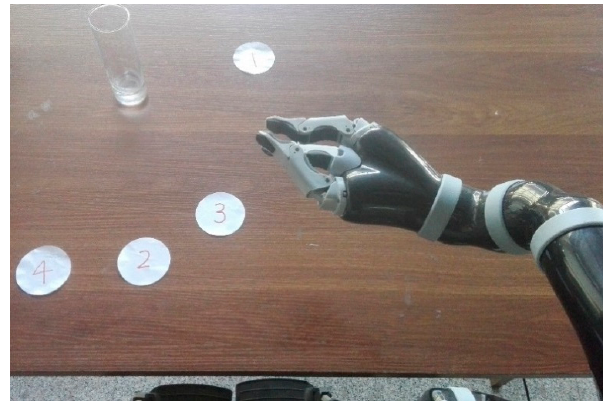
Figure 7. Experiment setting of placing a cup on the table. Cup initial position: 1; demonstration goal position: 2; new goal positions: 3, 4; demonstration 1: from 1 to 2; replay task 1: from 1 to 3; replay task 2: from 1 to 4.